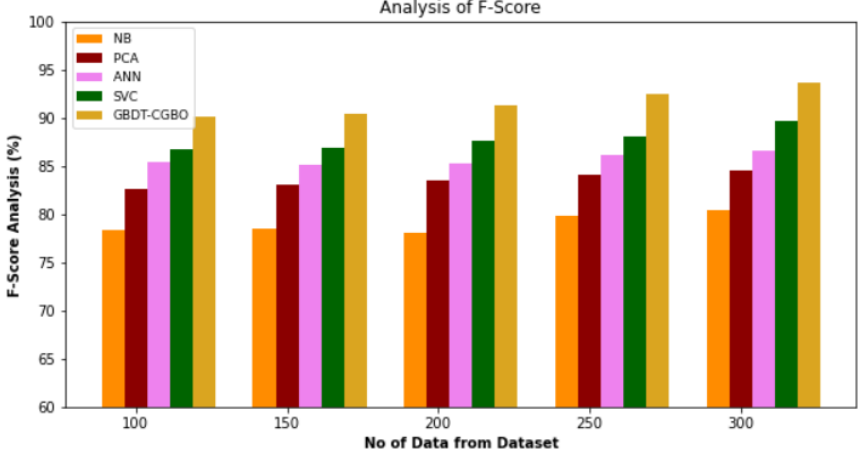
Table 3. F-Score Analysis of GBDT-CGBO method with existing system in percentage.